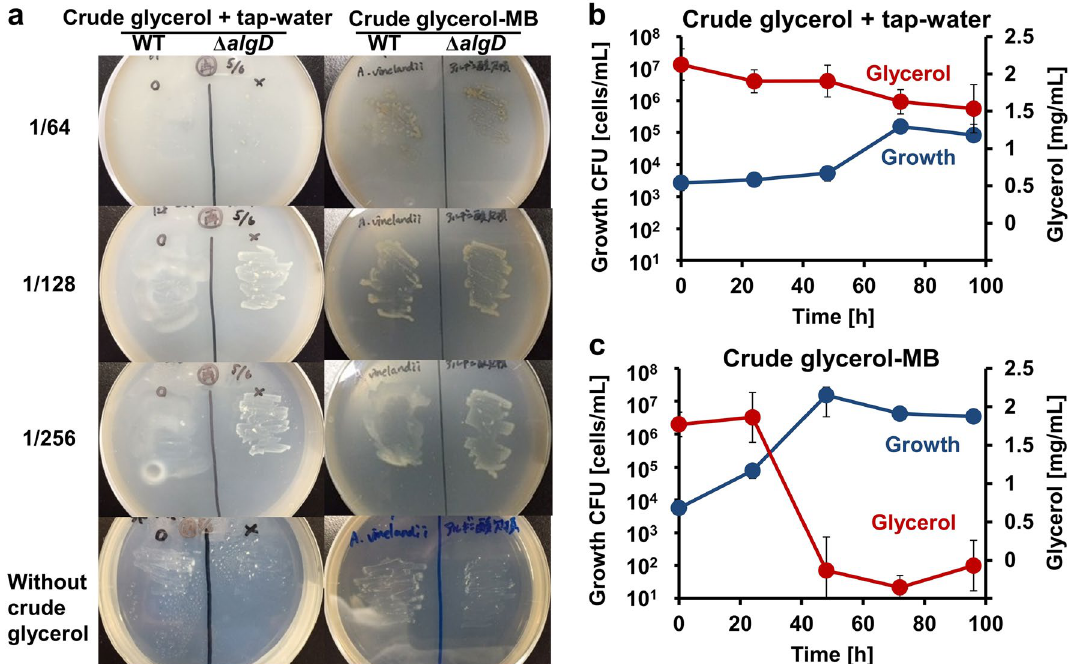
Figure 1. Crude glycerol assimilation by A. vinelandii . ( a ) Growth of A. vinelandii wild-type and Δ algD cells on crude glycerol plate medium. The labels (1/64, 1/128, and 1/256) on the left side represent the dilution fold. ( b ) Bacterial CFU (cells/mL) and residual glycerol concentration in 256-fold diluted crude glycerol medium. Blue and red-colored circles represent CFU and glycerol concentration, respectively. ( c ) Bacterial CFU (cells/mL) and residual glycerol concentration in 1/256-fold diluted crude glycerol-MB medium. Blue and red-colored circles represent CFU and glycerol concentration,